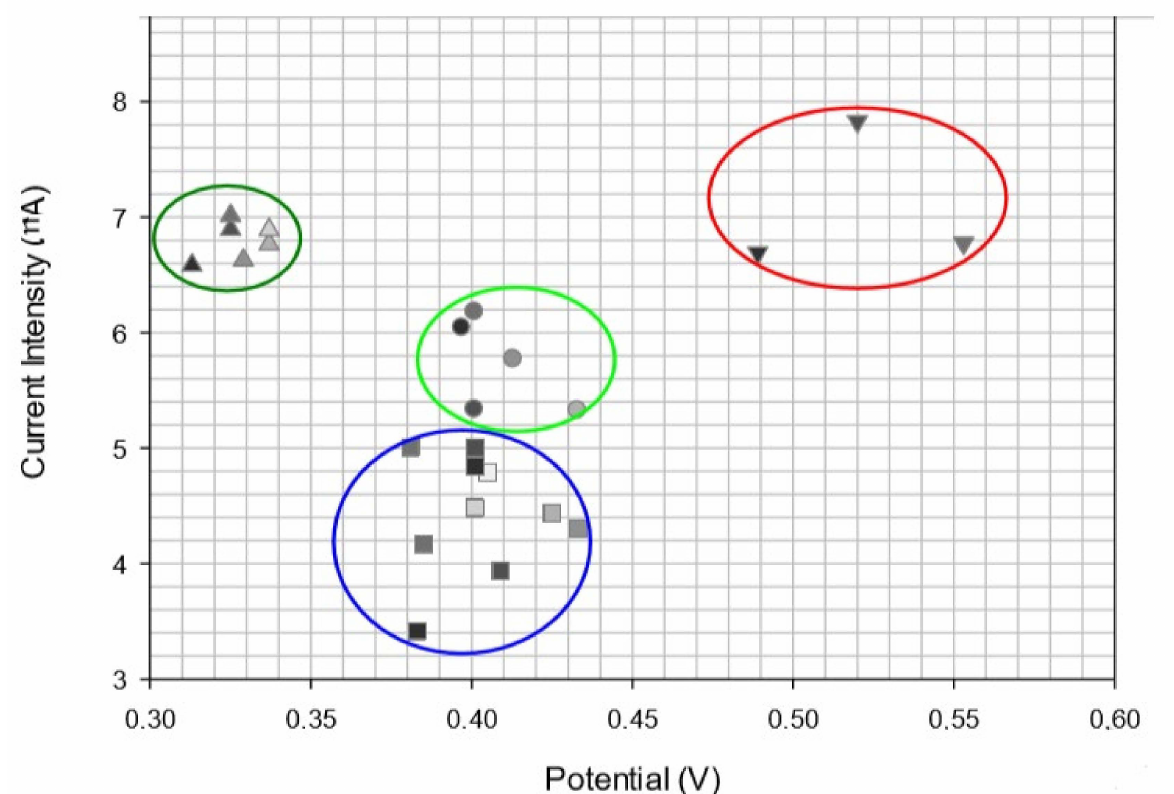
Figure 8. Analysis of extra virgin olive oils from various regions in Italy. Working electrode: GC/MWCNT/[Ch][Phe]/lipase. The points in the chart correspond to the various oil samples. Each geographic region is represented by: (cid:78) the south of Italy (cid:72) Tuscany • Abruzzo (cid:4) Lazio. Published from [175] with the permission of the